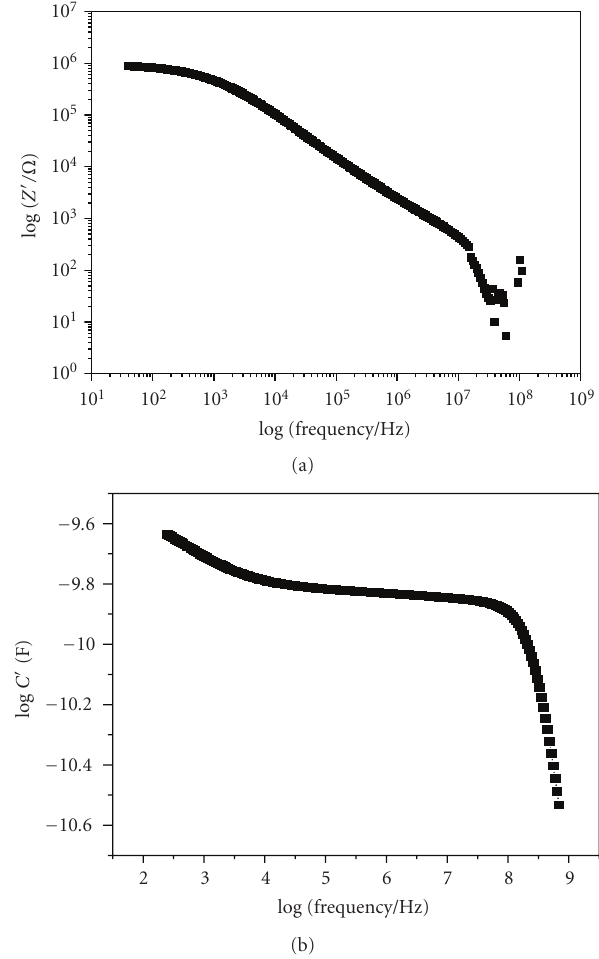
Figure 7: Bode capacitive diagrams for the SBTi film, logarithm of real part of the complex capacitance as a function of